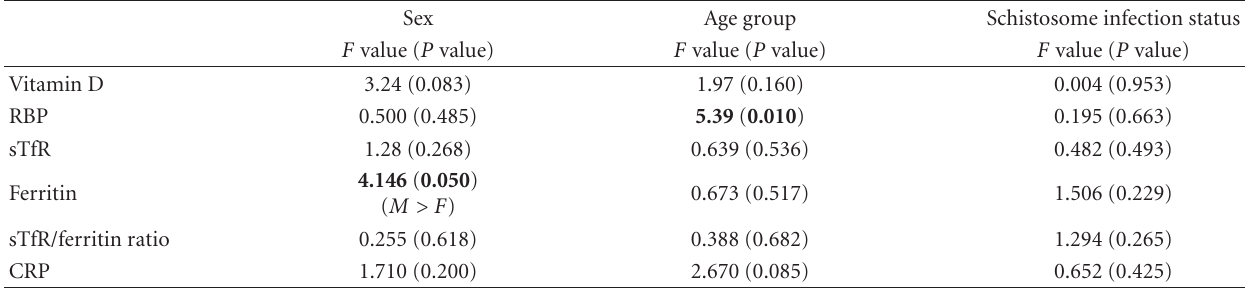
Table 1: List of factors whose association with micronutrient levels was tested with ANOVA. F and P values are given for each